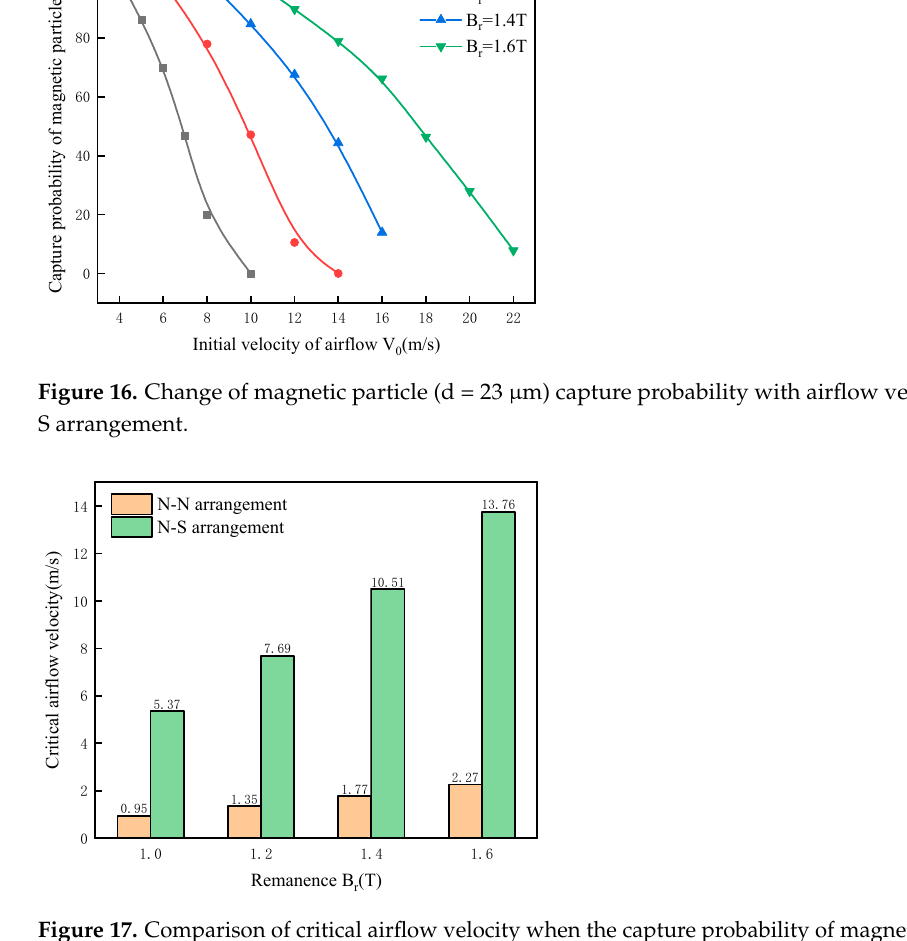
Figure 17. Comparison of critical airflow velocity when the capture probability of magnetic particles (d = 23 μ m) is 80% under different arrangement of magnetic